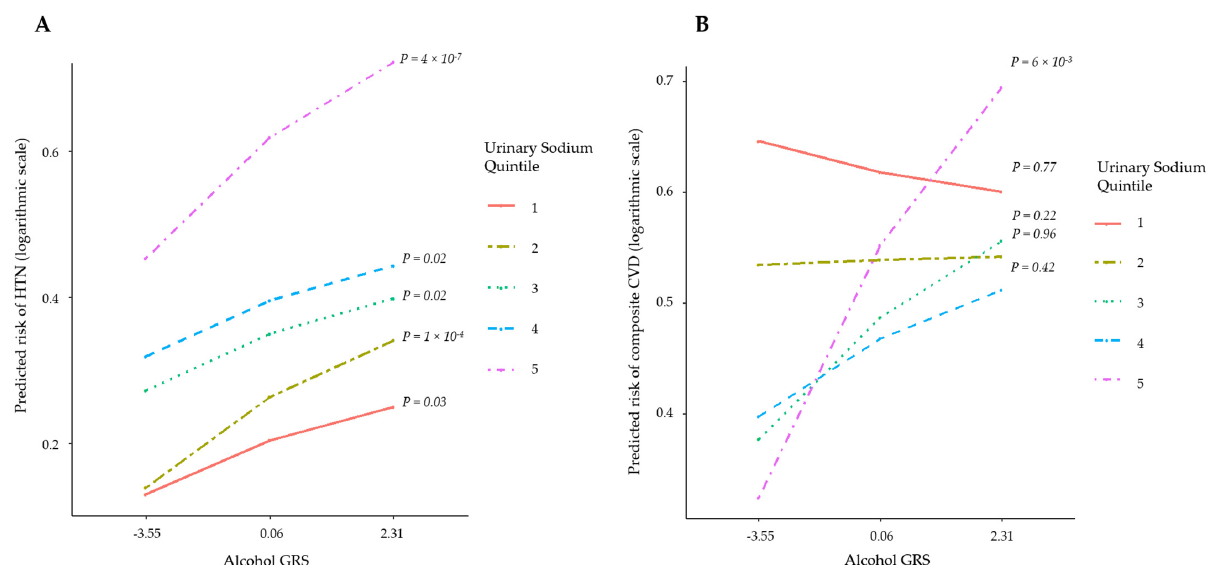
Figure 4. Effect of the alcohol genetic risk score (GRS) on ( A ) hypertension and ( B ) cardiovascular disease across urinary sodium excretion quintiles. X axis shows the median values of GRS in GRS quintile 1, 3, and 5, respectively: − 3.549, 0.058, and 2.312.